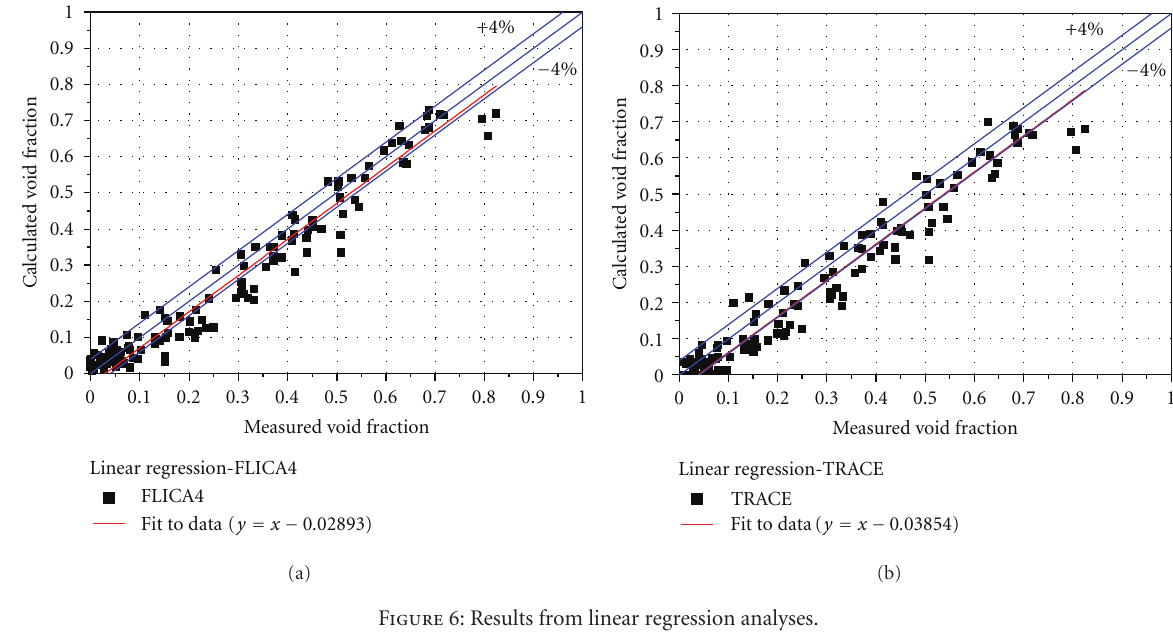
Figure 6: Results from linear regression analyses.